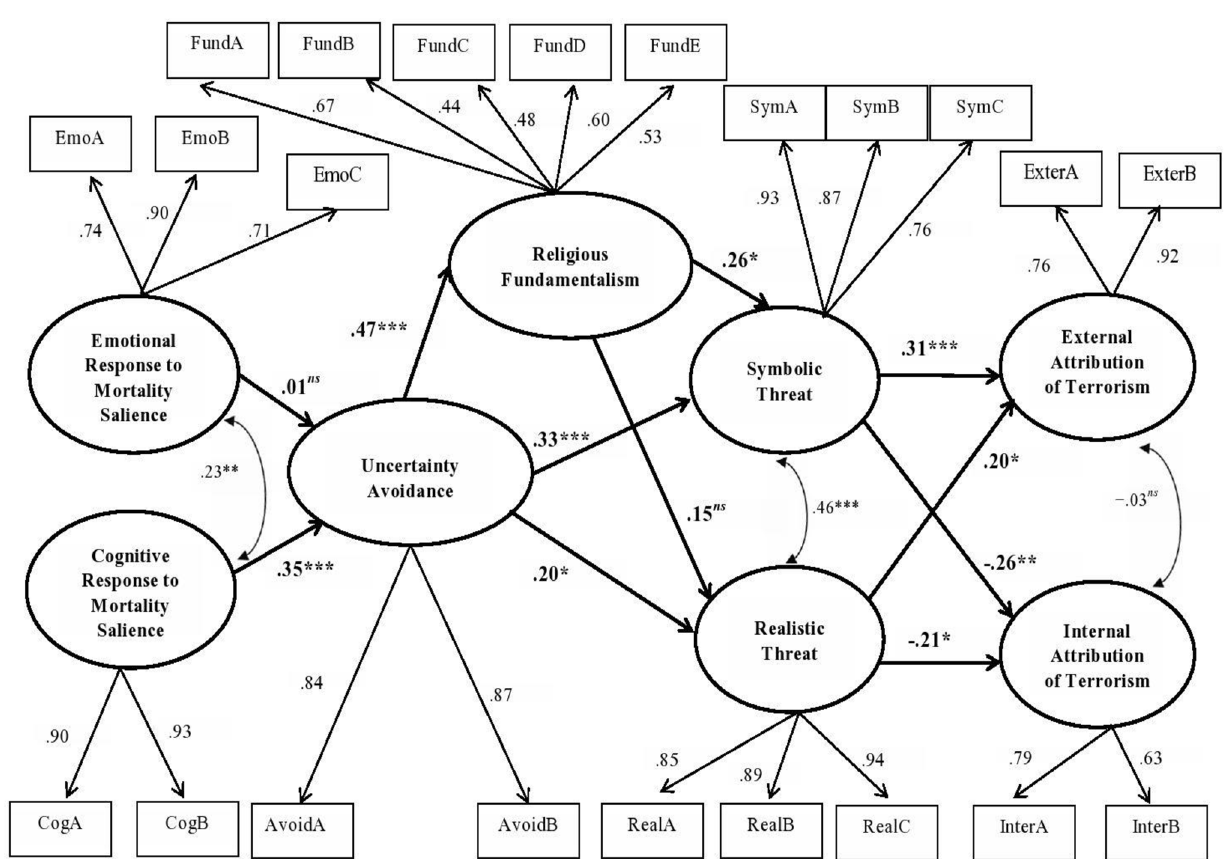
Figure A.2. The Alternative Model 1 in which uncertainty avoidance is the antecedent of religious fundamentalism. Note . The numbers were standardized path coefficients and factor-loadings. ExterA−ExterB = External Attribution of Terrorism Parcel A and Parcel B; InterA−InterB = Internal Attribution of Terrorism Parcel A and Parcel B; SymA−SymC = Symbolic Threat Parcel A, parcel B, and Parcel C; RealA−RealC = Realistic Threat Parcel A, parcel B, and Parcel C; AvoidA−AvoidB = Uncertainty Avoidance Parcel A and Parcel B; FundA−FundE = Religious Fundamentalism Parcel A, Parcel B, Parcel C, Parcel D, and Parcel E; EmoA−EmoC = Emotional Response to Mortality Salience Parcel A, Parcel B, and Parcel C. CogA-CogB = Cognitive Response to Mortality Salience Parcel A and Parcel